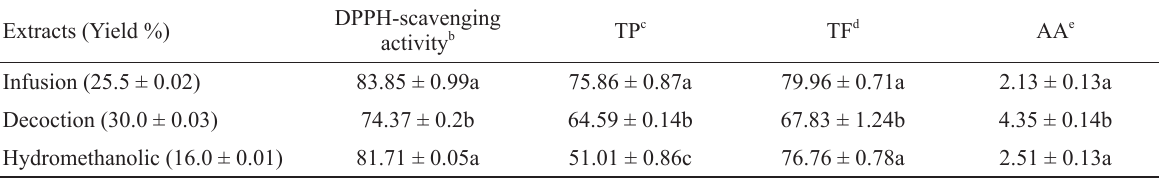
DPPH-scavenging activity, total content of phenolics (TP), flavonoids (TF) and ascorbic acid (AA) from Morus nigra according to the extraction method a